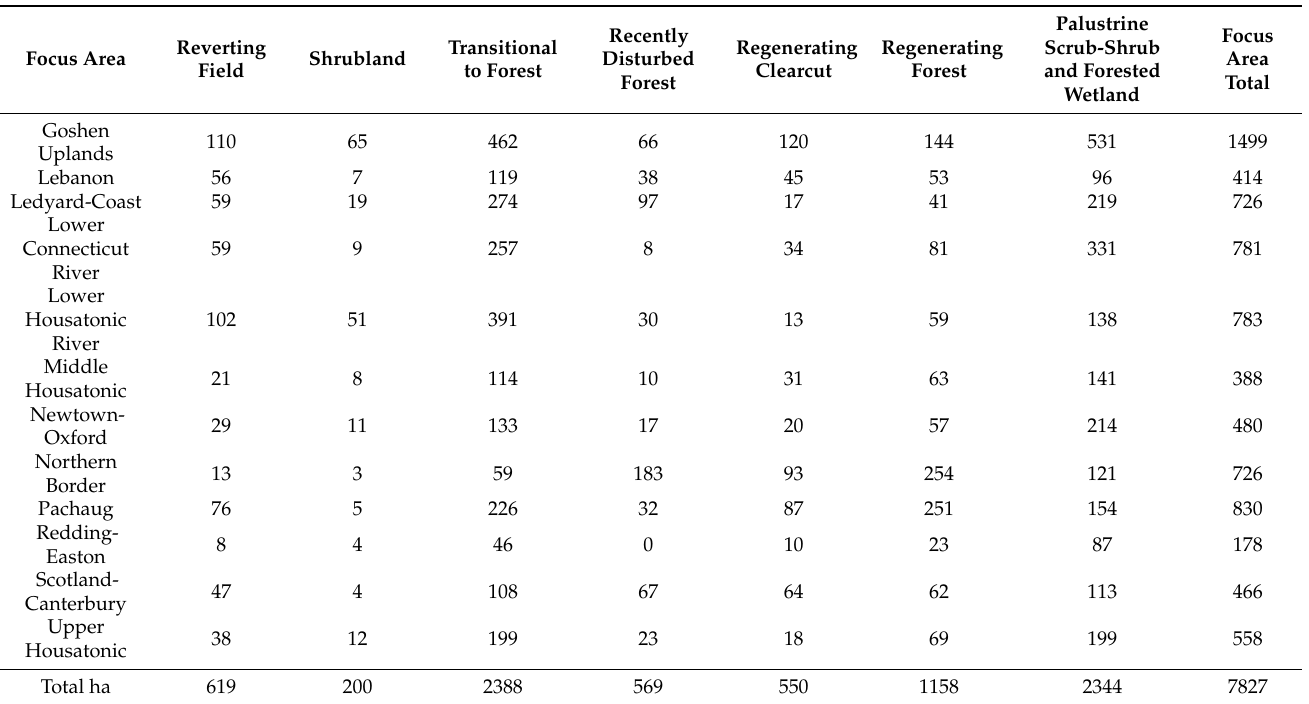
Table 5. Hectares of young forest and shrubland in complexes ≥ 2 ha, by New England Cottontail Focus